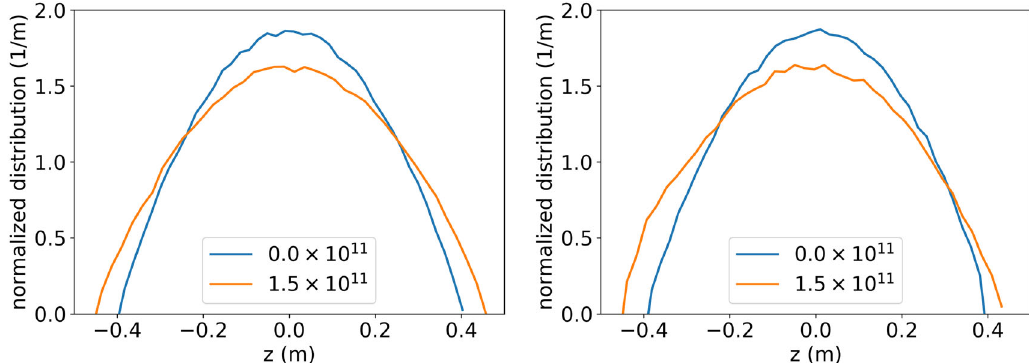
1 . 5 × 10 11 particles per bunch for the pure b ¼